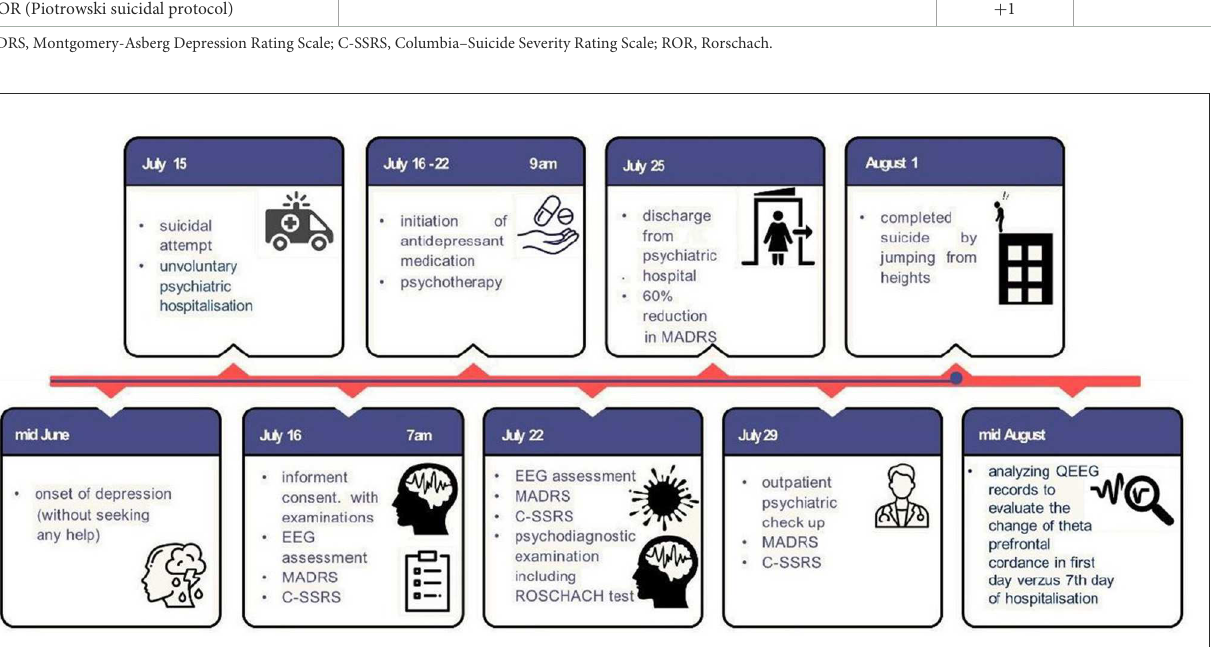
antidepressant (sertraline 100mg per day). He was